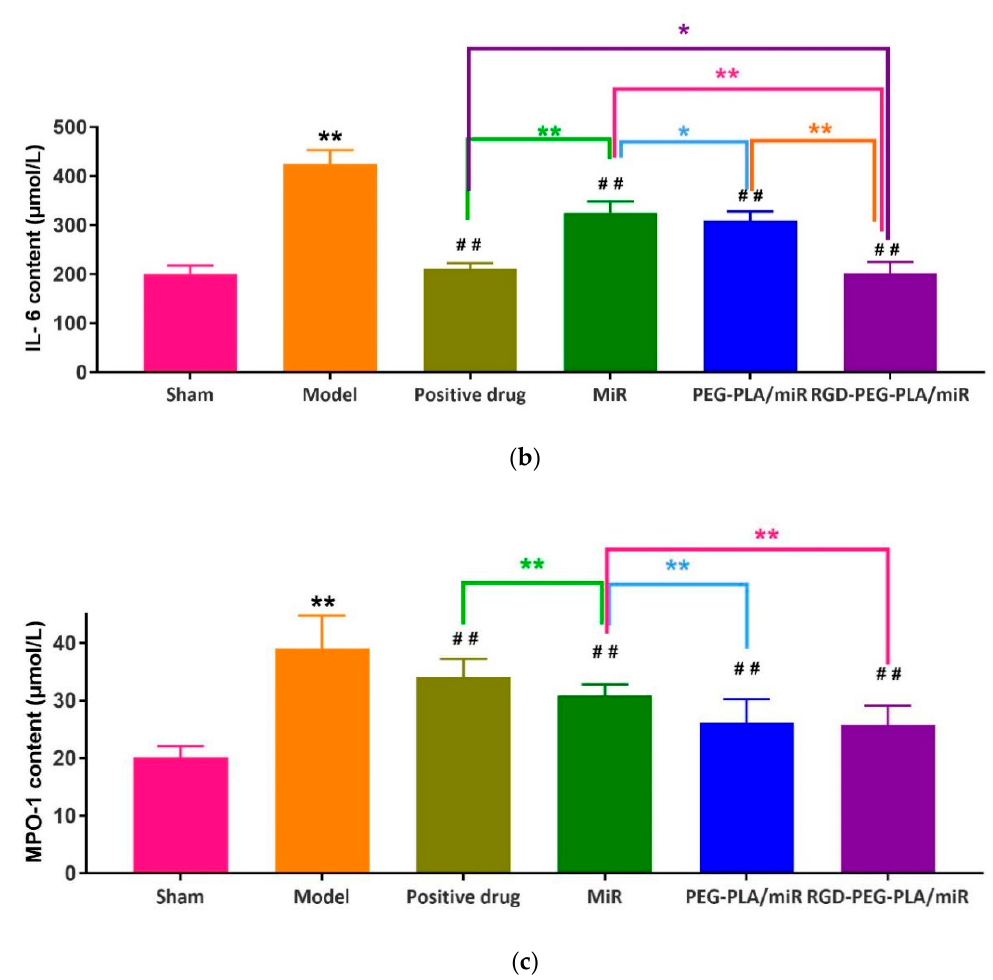
Figure 9. The contents of ( a ) tumor necrosis factor- α (TNF- α ), ( b ) interleukin-6 (IL-6), and ( c ) myeloperoxidase-1 (MPO-1) in six groups of rats (mean ± SD, n = 6). Compared with the sham group, the difference was statistically significant (** p < 0.01). Compared with the model group, the difference was statistically significant ( # p < 0.05, ## p < 0.01). The color asterisks indicate significant differences between the two groups, * p < 0.05 and ** p < 0.01.